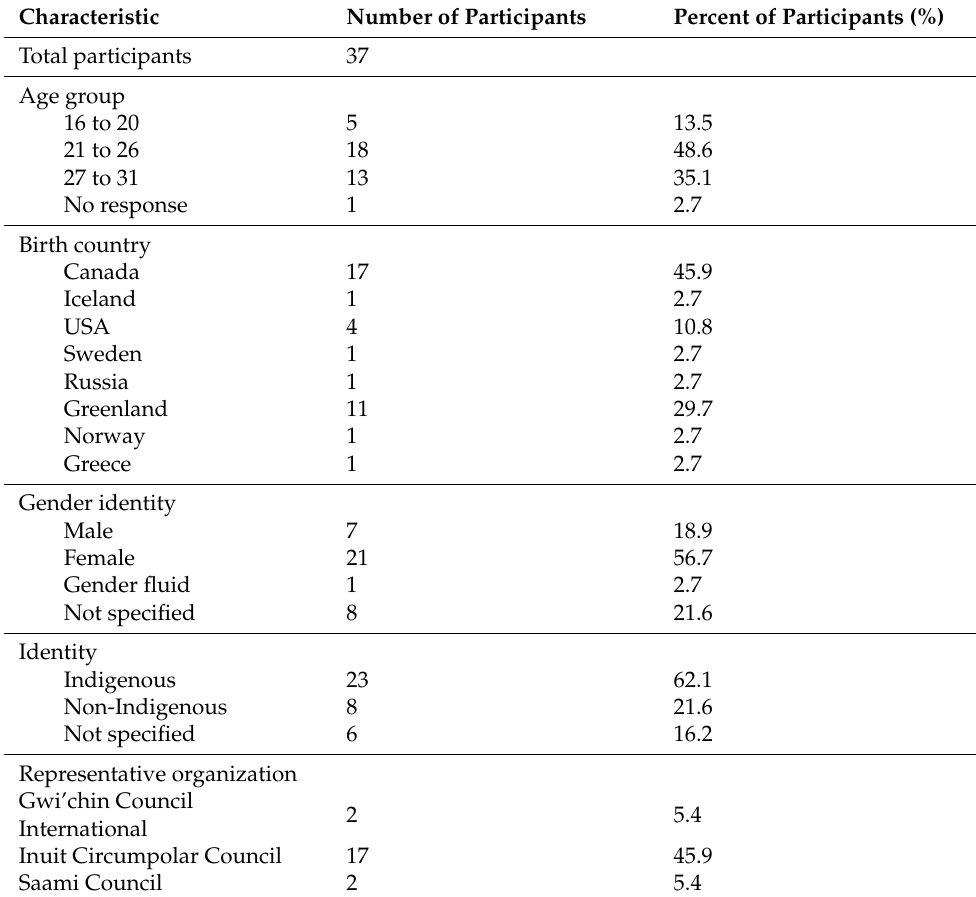
Table 1. Characteristics of AYWN